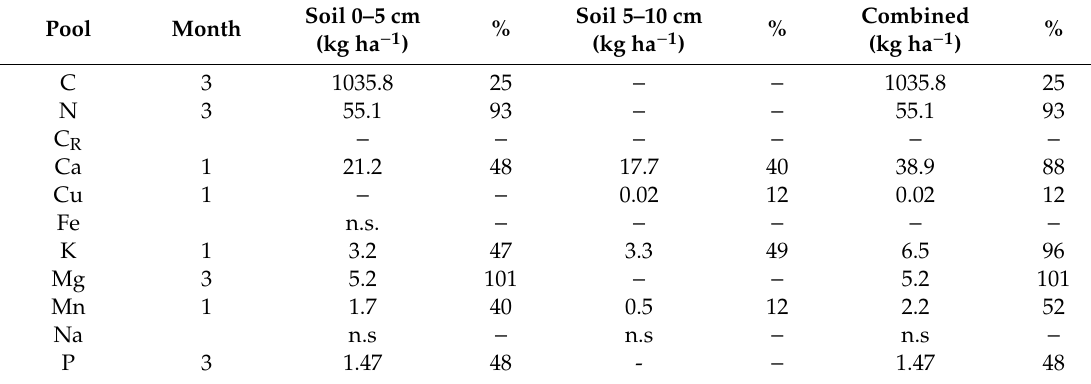
Table 2. Peak retention of C, N and nutrients released via combustion from forest floor layer (Table 1) by soil at depths of 0–5 and 5–10 cm during 12 months of monitoring. The timing of peak retention is indicated by the variable